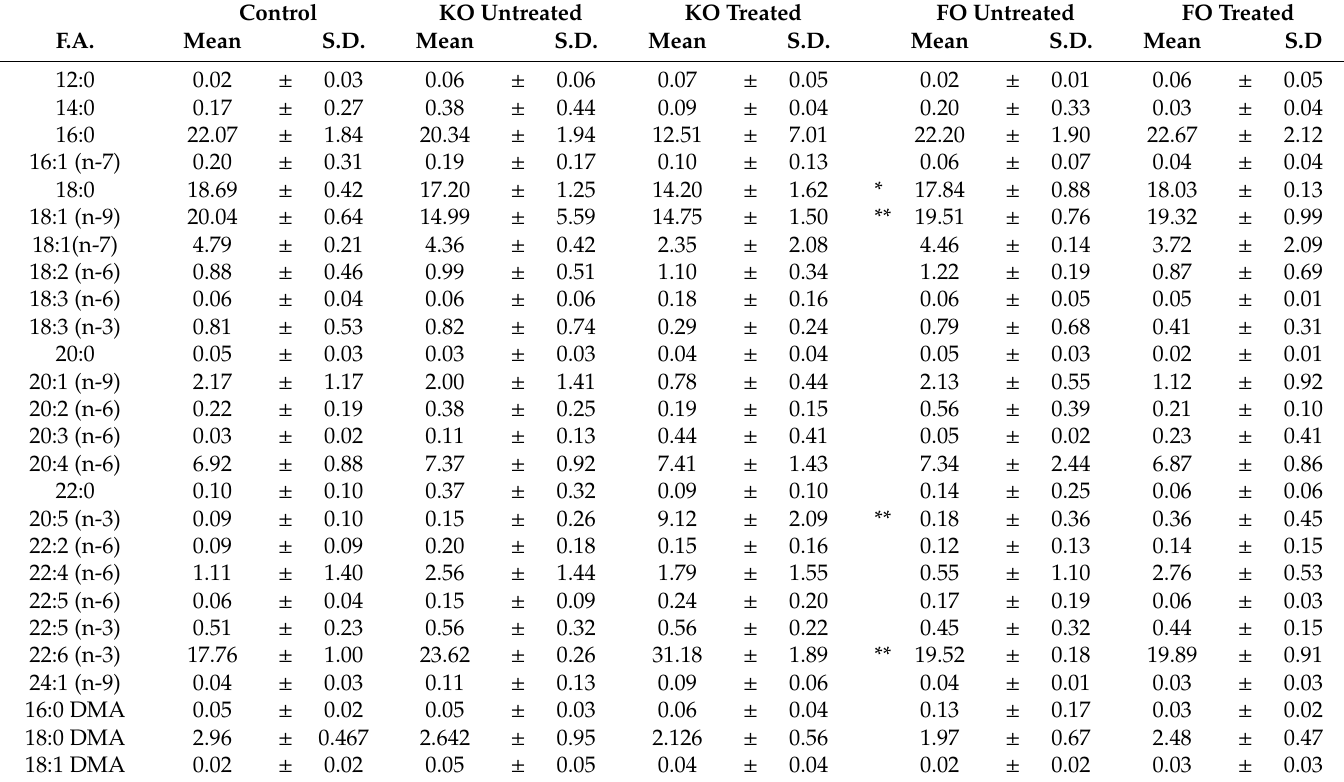
Table 3. E ff ect of feeding unmodified, and lipase-treated krill oil and fish oil on mouse retina fatty acid composition.